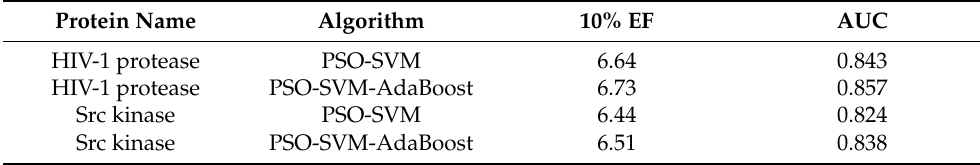
Table 2. After sampling, the indexes of the two classification methods are compared.